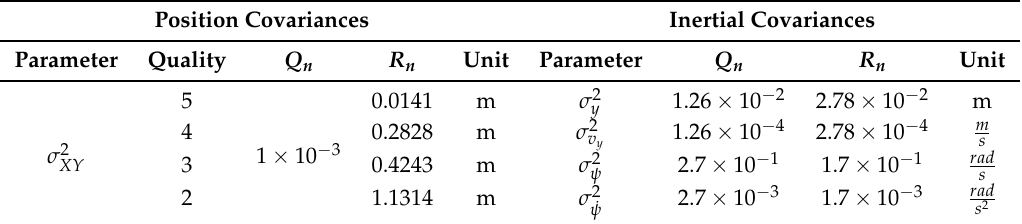
Table 2. Process and measurement covariances in